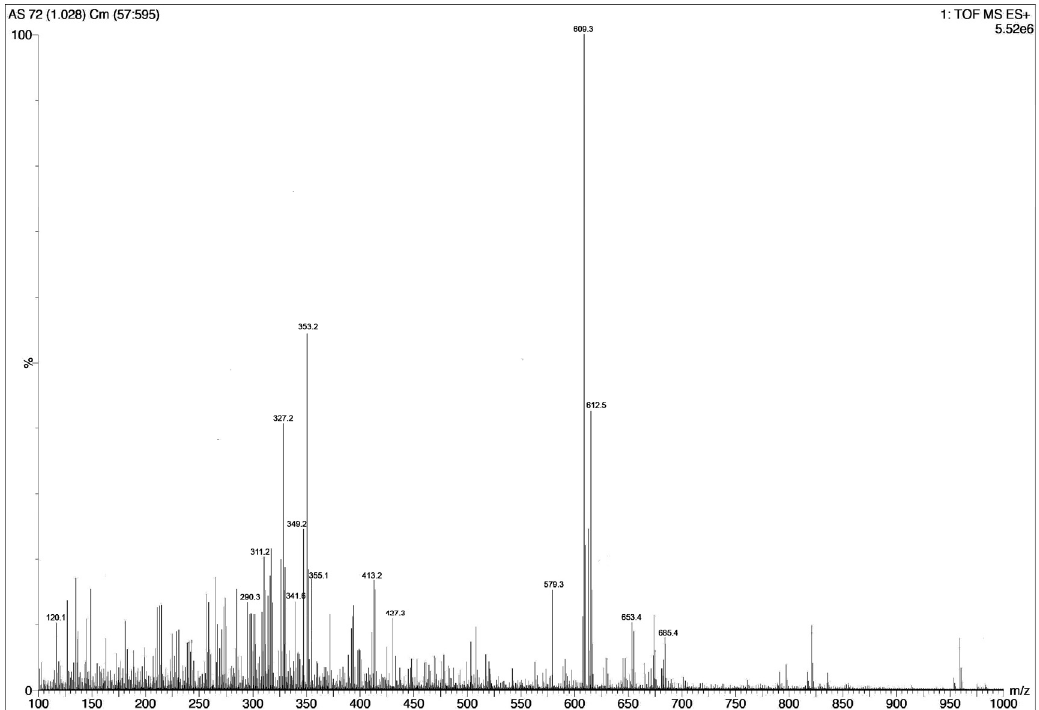
Figure 2. Total mass spectrogram of R. serpentina extract in positive mode ESI showing peaks of masses present. Highest m / z 609 reflects reserpine and m / z 353 reflects ajmalicine presence, n = 4 individual LCMS runs.